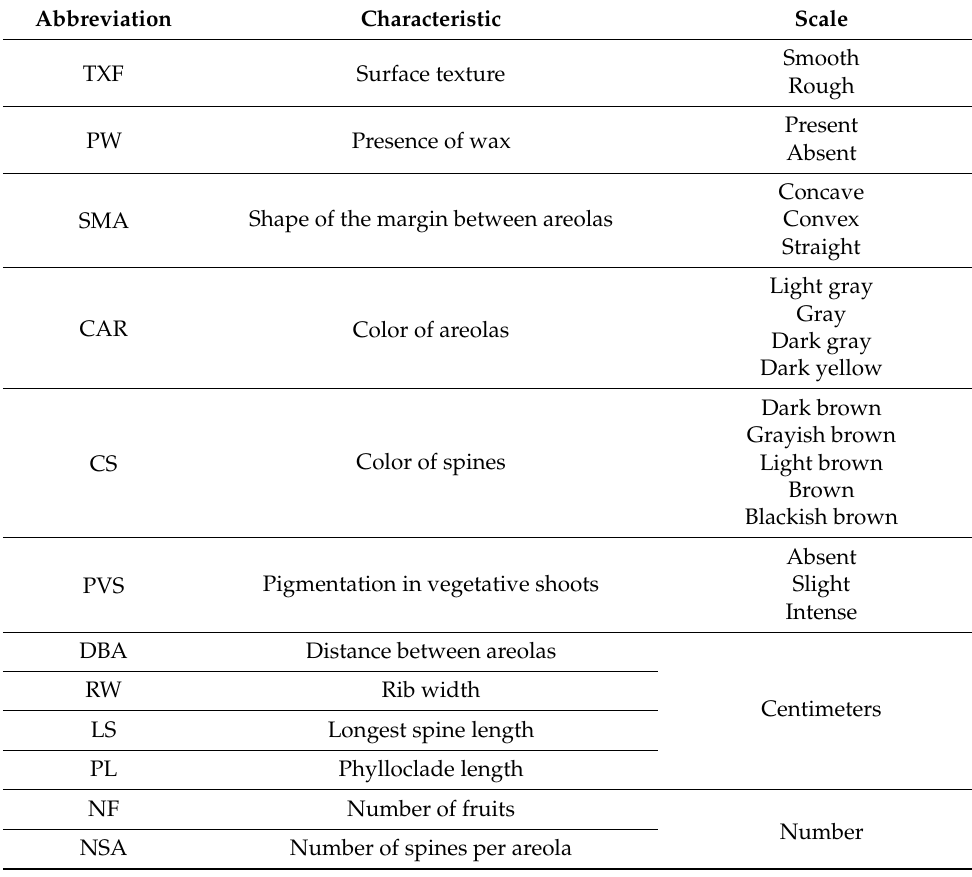
Table 2. Descriptors used in the morphoagronomic characterization of phylloclades.